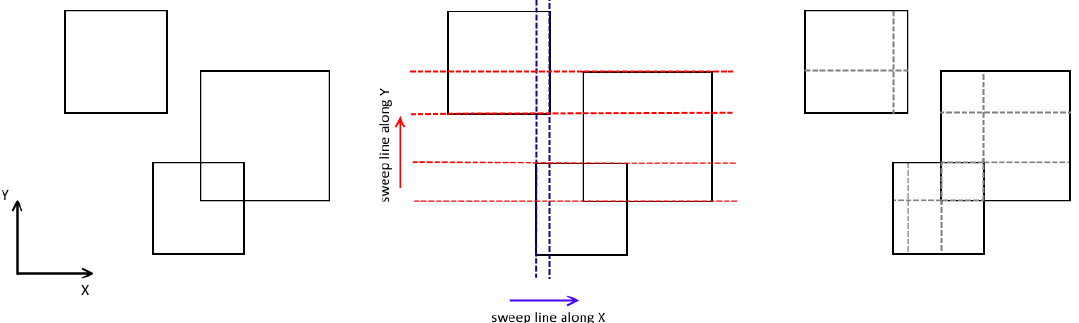
Figure 4. Sweep line example: ( Left ) initial state (projections of particles on XY plane); ( Middle ) sweep line cut area; and ( Right ) final